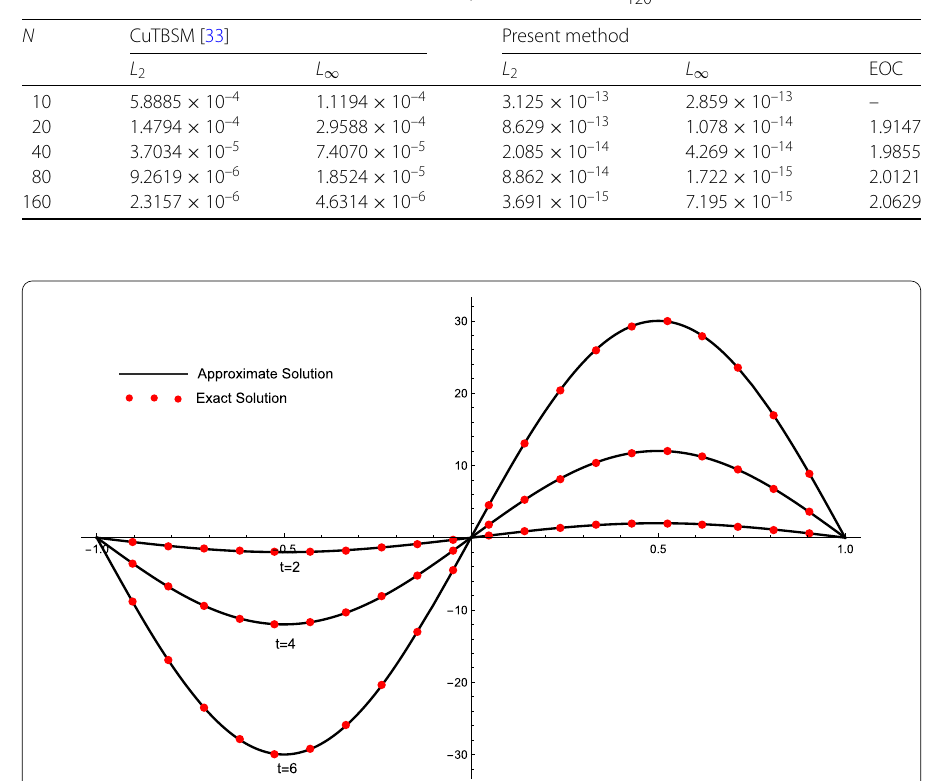
Figure 1 Exact and approximate solutions for Example 1 at t = 2,4,6 when N = 10, α = 1.5 and –1 ≤ z ≤